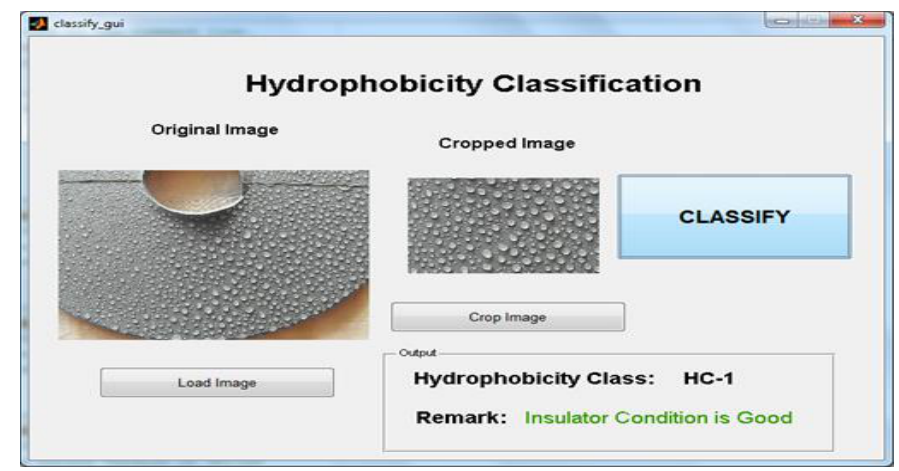
Figure 13. GUI for hydrophobicity classification.